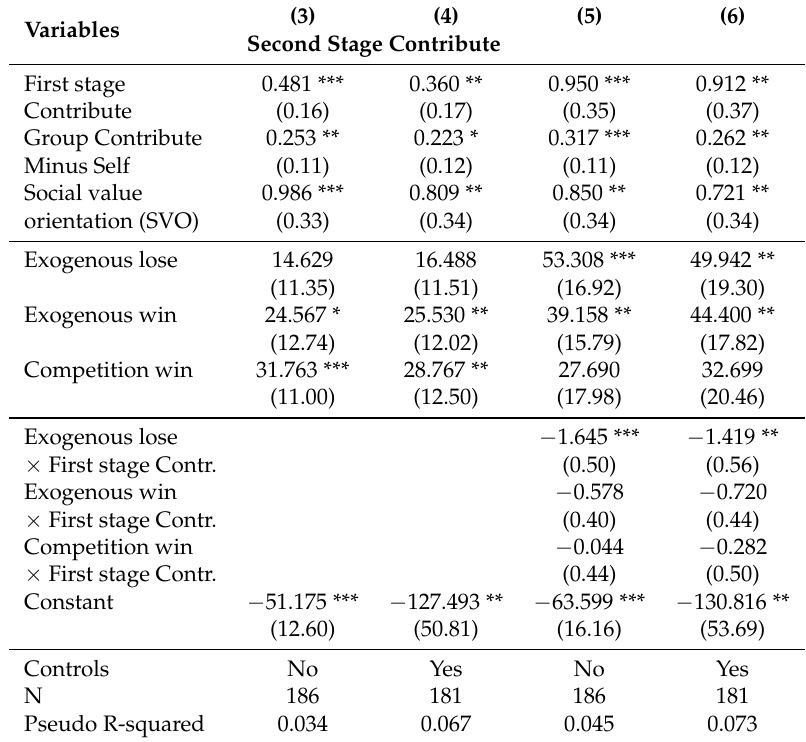
Table 3. Determinants of second stage contribution. Tobit model with limits at 0 and